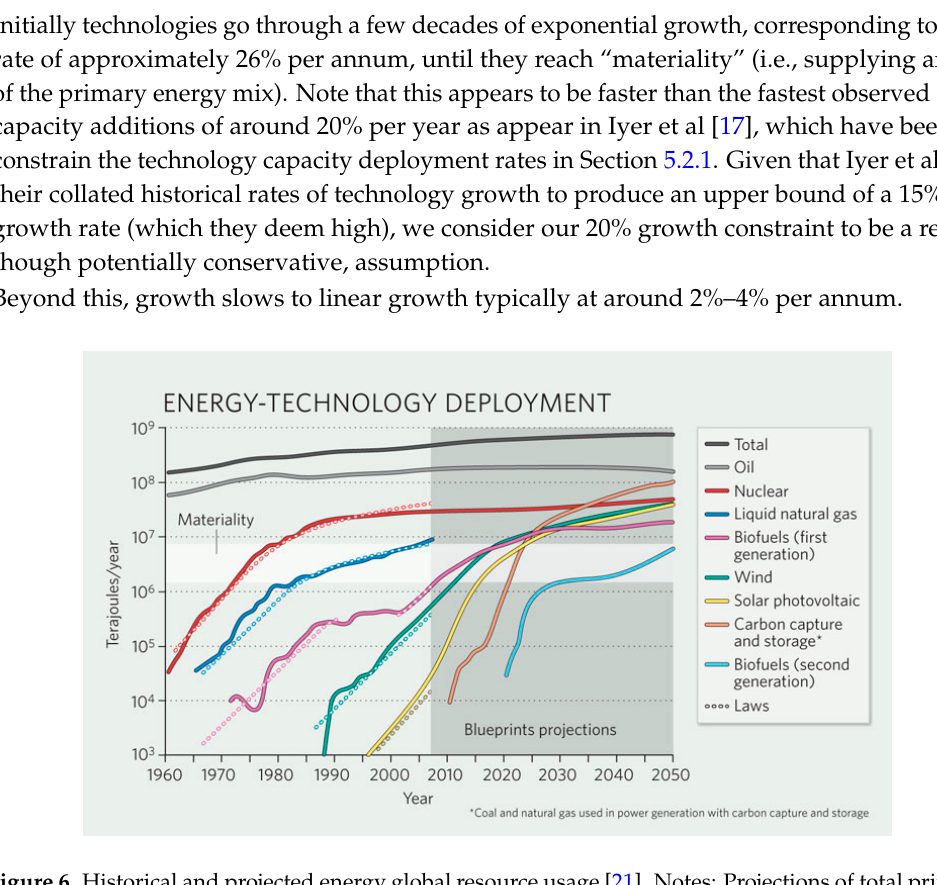
Figure 6. Historical and projected energy global resource usage [21]. Notes: Projections of total primary energy supplied (in TJ per year) from Shell’s Blueprints scenario (with historical data provided to 2010). Materiality band (shown in white) indicates an approximate level of 1% of global primary energy supply for each resource. Historically, energy resources have been observed to transition from an exponential growth path to a linear growth path once they have reached materiality.